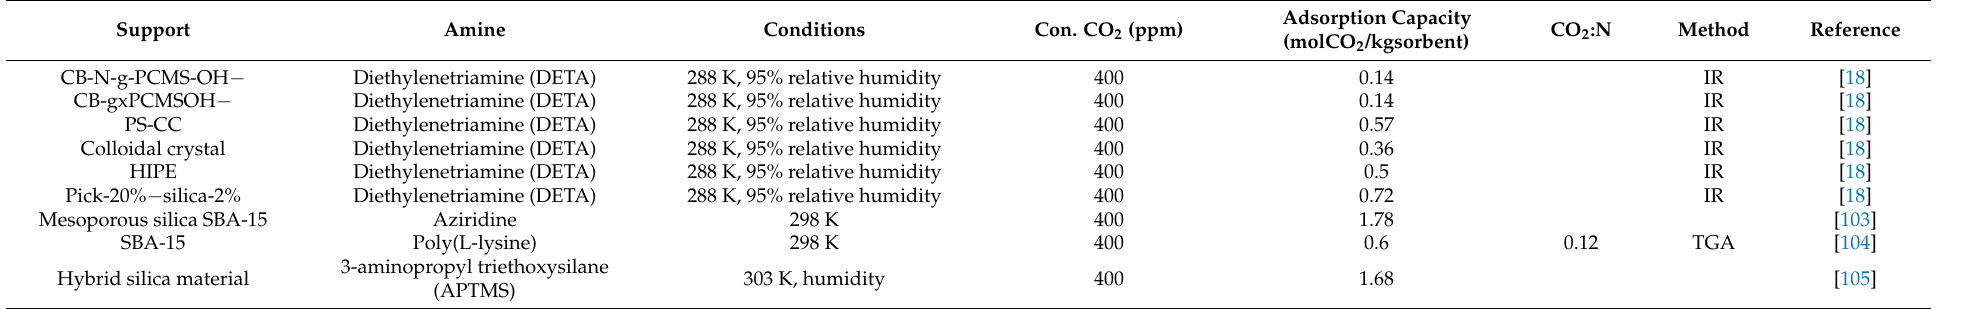
Table 4. Class III amine-functionalized